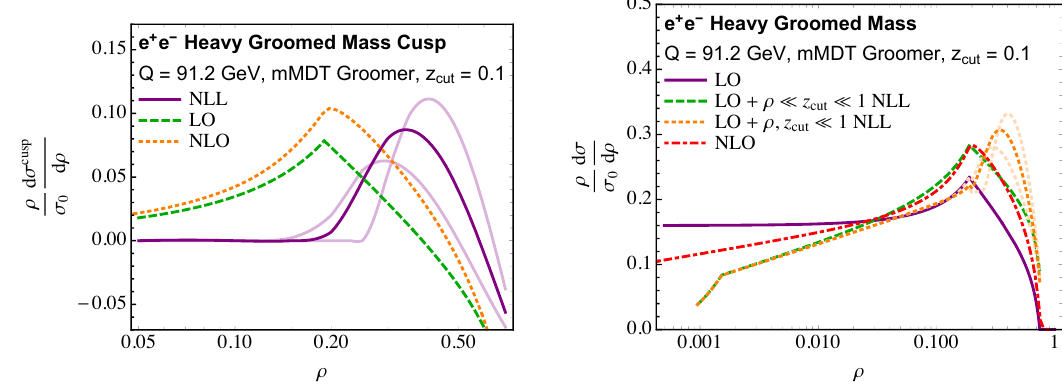
Figure 5 . Plots comparing the NLL resummation of the cusp region eq. (5.1) to other calculations. Left: comparison of the cusp resummation to the cusp at leading- and next-to-leading fixed order. The darker NLL distribution uses canonical scales, while the lighter curves to the left (right) vary the scale of the soft function up (down) by a factor of 2. Right: comparison of the full groomed heavy hemisphere mass distribution at fixed-order and matched to resummed results. Again, the lighter curves correspond to variation of the soft scale in the NLL cusp resummation up or down by a factor of